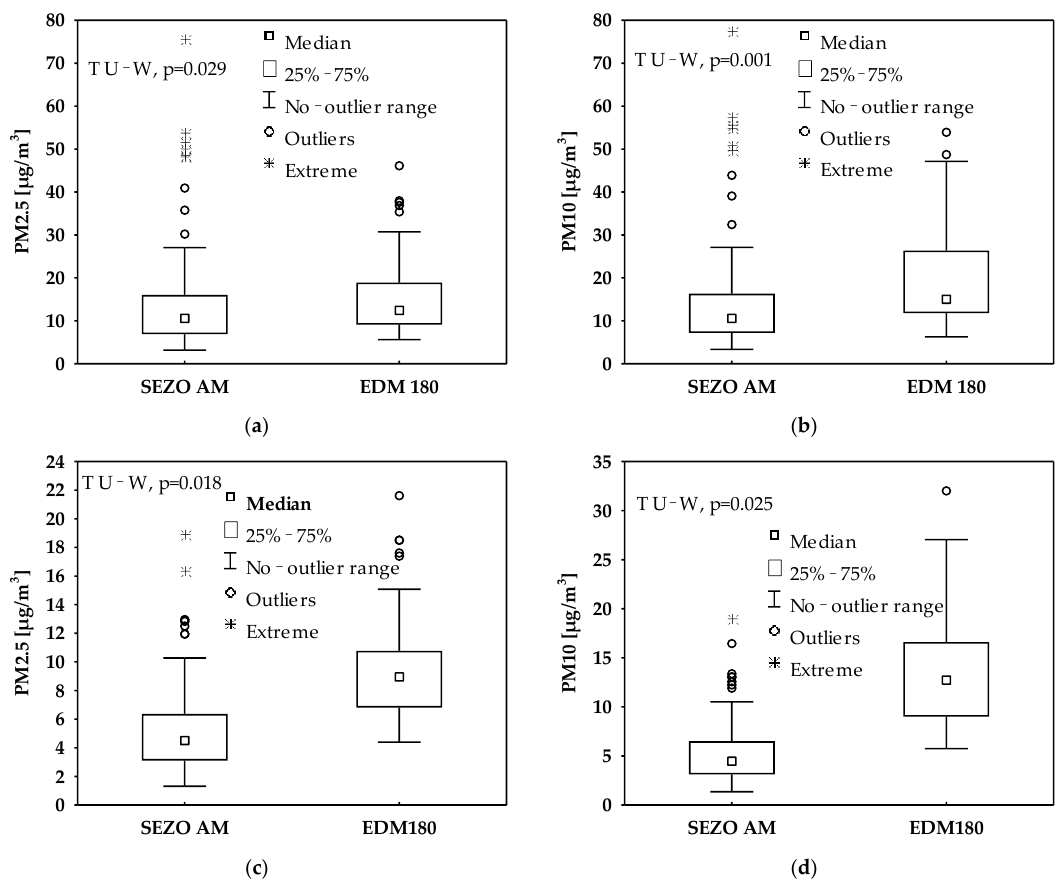
Figure 7. Statistical characteristics of the results of ( a ) PM2.5 and ( b ) PM10 concentrations measured in the period from 1 March to 30 April 2021 and for ( c ) PM2.5 and ( d ) PM10 in August – September at the AM4 station in Gdynia using the SEZO AM and EDM 180 methods.